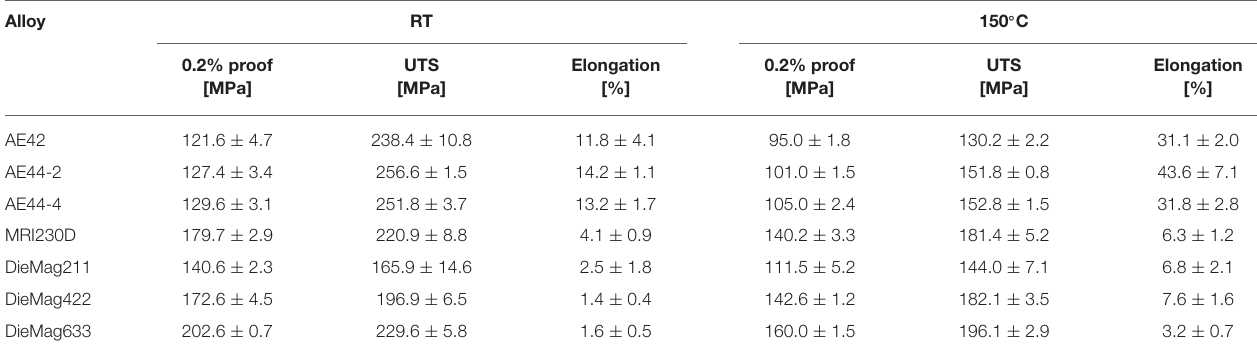
TABLE 3 | Tensile properties at RT and 150 ◦